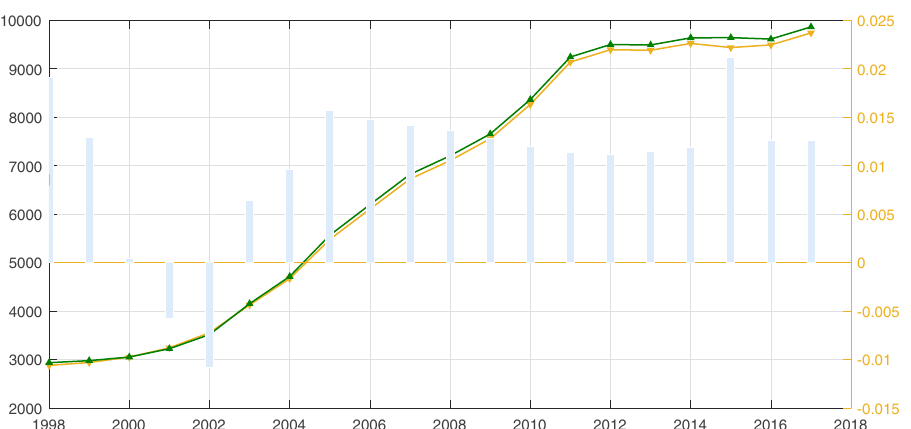
Figure 2. Comparison of our simulated total carbon emissions and actual total carbon emissions estimated from provincial energy balance tables during 1997–2017 (unit: million